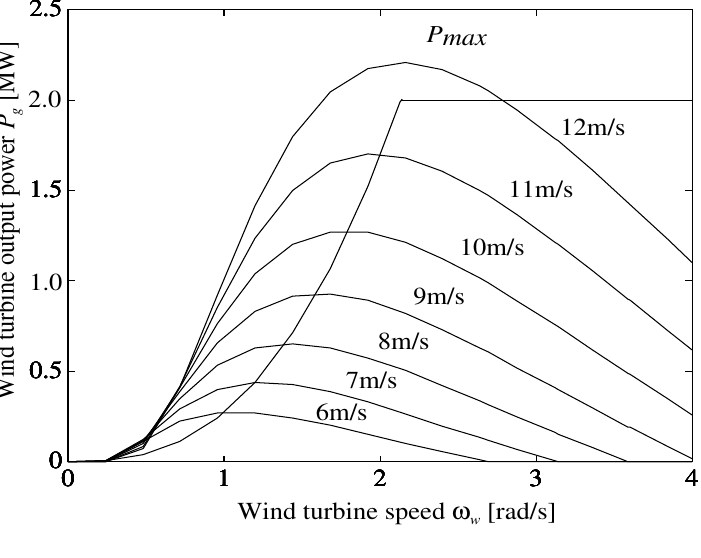
Figure 3. Pitch angle control